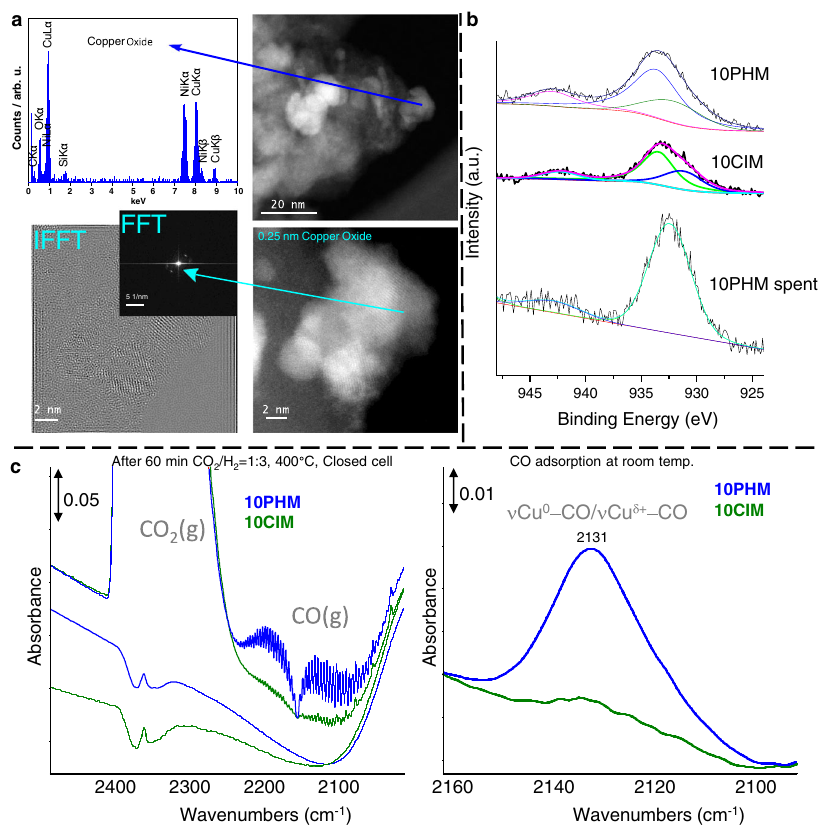
Fig. 2 | Catalyst characterizations. a STEM-HAADF images, EDXS and FFT/IFFT of fresh10Cu/SiO 2 -PHMsample. b XPSspectraof 10Cu@SiO 2 -PHM,10Cu@SiO 2 -CIM, and10Cu@SiO 2 -PHM-spentsamples. c InsituFTIRspectraof10Cu@SiO 2 -PHMand